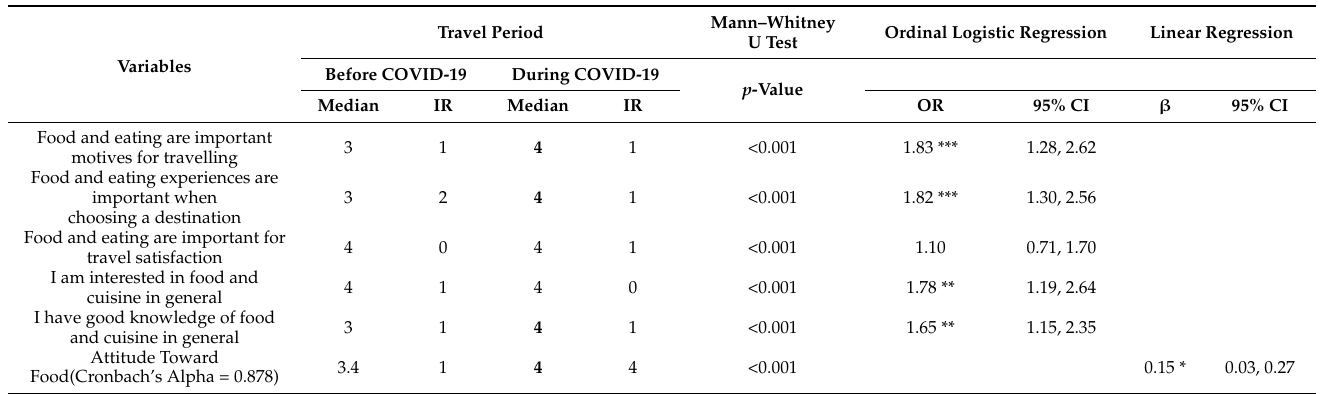
Table 6. Attitudes toward food of tourists in each